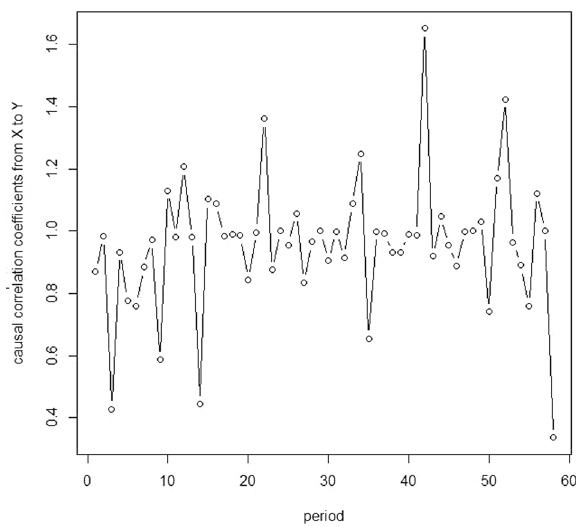
Fig. 3 Hausdorff average distances between optimal empirical and absolute causal relations. The solid line stands for the absolute causal relations from MHP (or X) to MSP (or Y), while the dashed line stands for the absolute causal relations rom MSP (or Y) to MHP (or X).